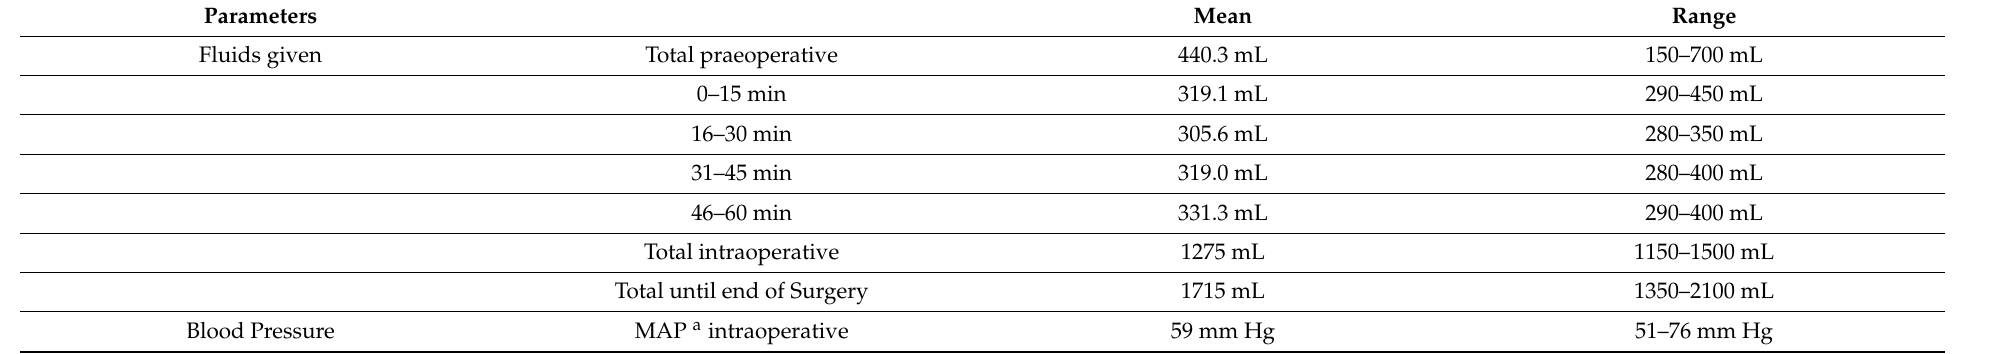
Table 2. Results Study Group, ( n =